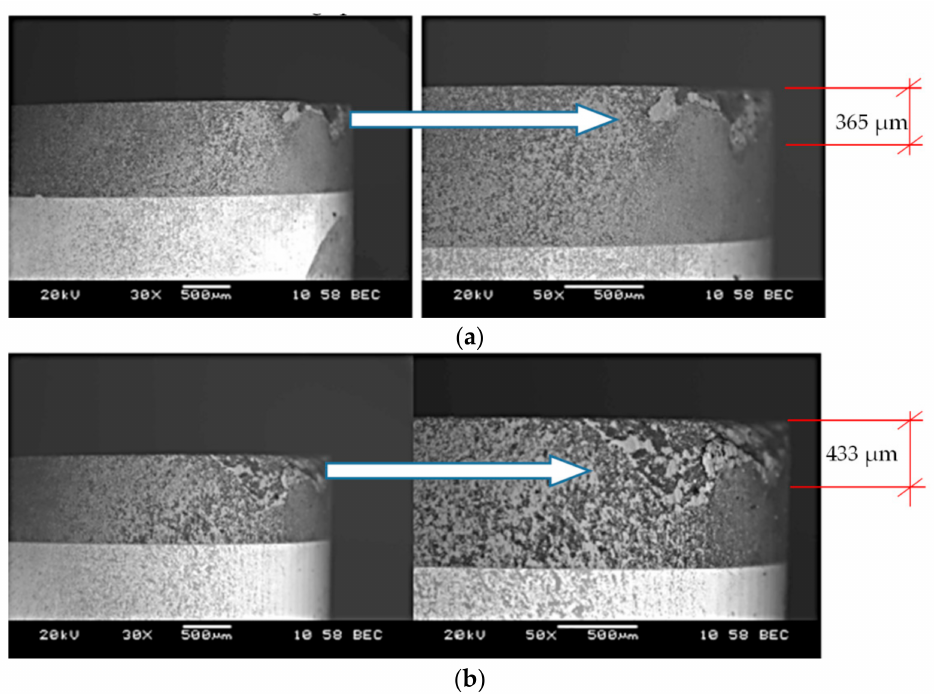
Figure 5. Sample photos of cutting edge wear on the cutting insert flank for ( a ) v c = 160 m/min;